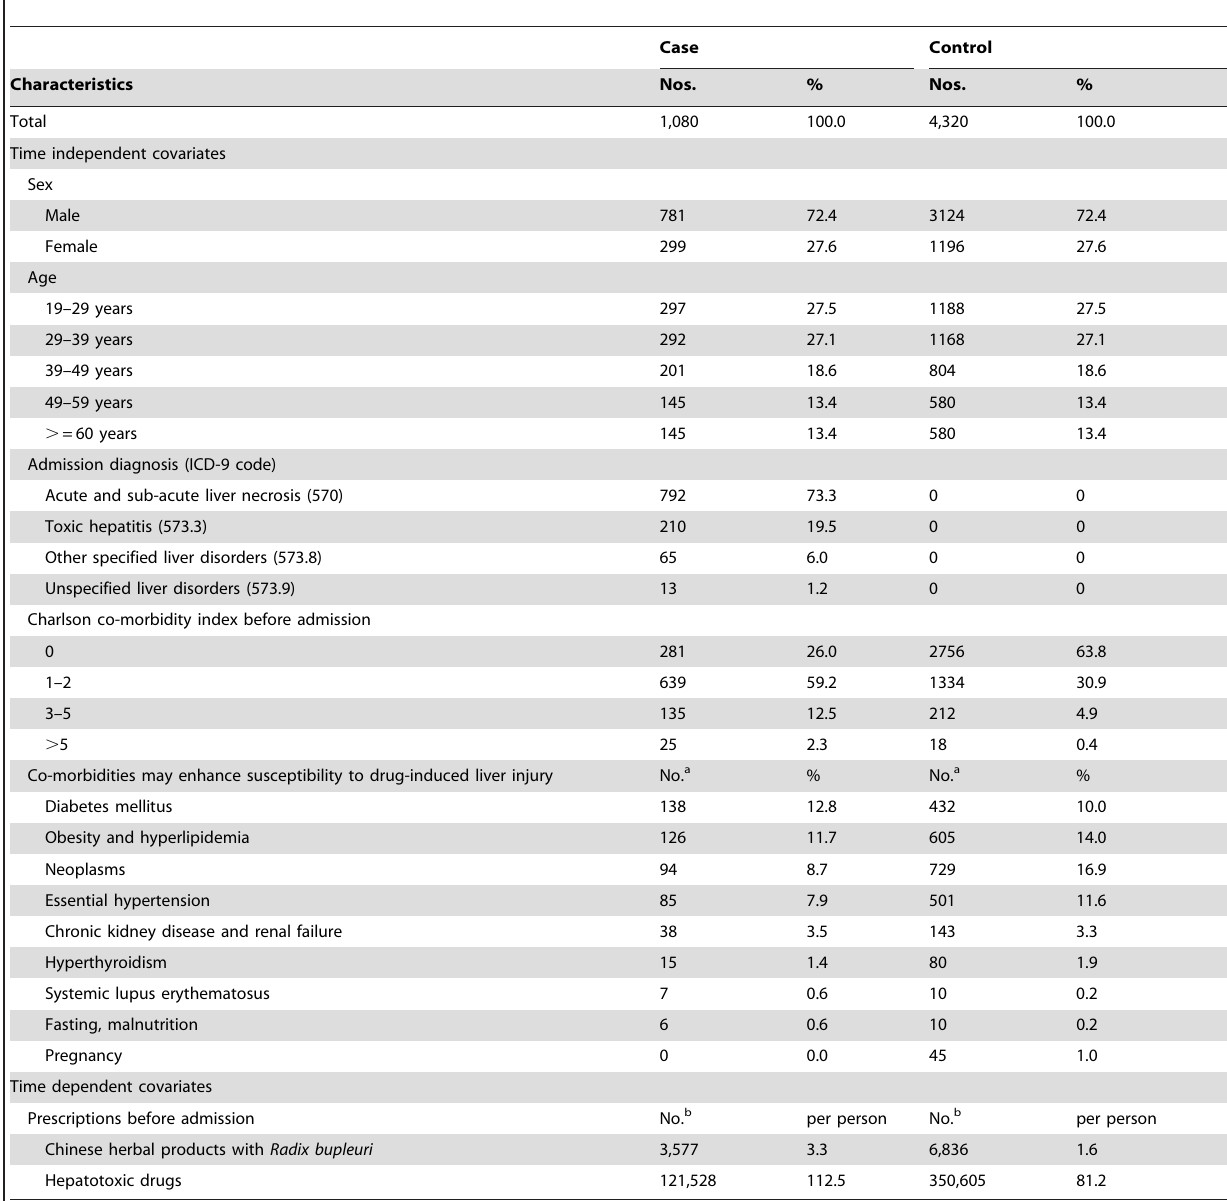
Table 1. Characteristics, co-morbidities, prescriptions and time-dependent hepatotoxic drugs for study subjects with viral hepatitis B infection,